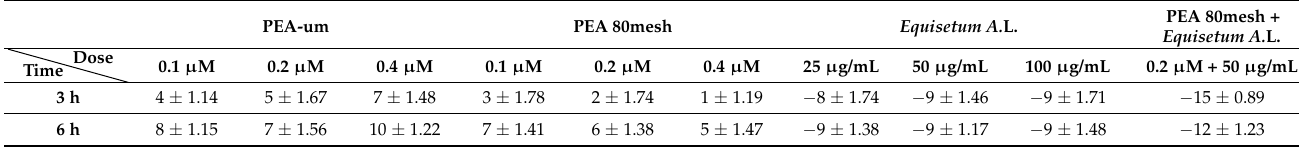
Table 2. Analysis of ROS production measured by cytochrome C reduction on CaCo-2 cells. The effects of PEA80mesh and Equisetum A. L., alone and combined, compared to PEA-um at 3 h and 6 h, were analyzed. Equisetum A .L. = Equisetum arvense L.; PEA-um = PEA ultra-micronized. The data are the mean ± SD (%) of five independent experiments performed in triplicate and normalized to control values